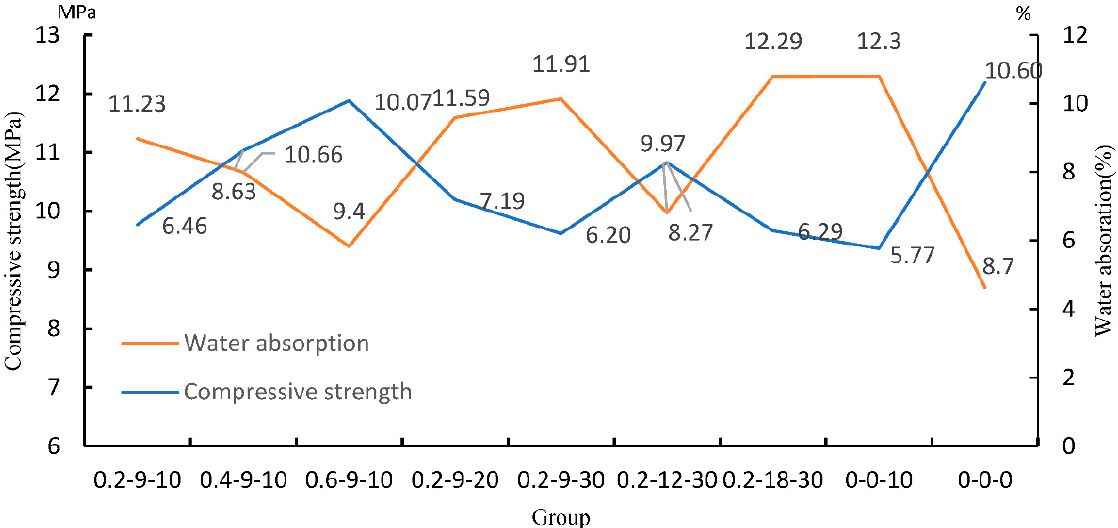
Figure 6. Diagram of water absorption and compressive strength.